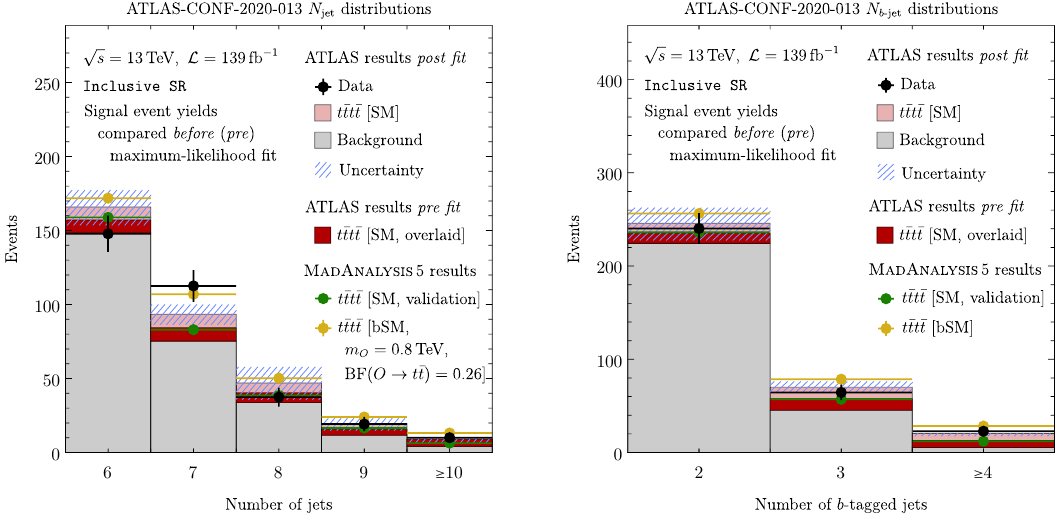
Figure 10 . Comparison between data and predictions for inclusive signal region events for the dis- tributions of (left) N jet and (right) N b -jet . Gray background results were obtained (and simplified) from figure 6 of ATLAS-CONF-2020-013 [3] and apply after the maximum-likelihood fit. Light (dark) red results were likewise obtained post (pre) fit from ATLAS and are overlaid, not stacked. Green results are derived from MadAnalysis 5 for SM t ¯ tt ¯ t production. Gold results are derived from MadAnalysis 5 for t ¯ tt ¯ t events mediated by a pair of 800 GeV scalar sgluons with branching fraction appropriate to fit thirty-event excess. Our sgluon yields are combined with ATLAS back- grounds and ATLAS pre-fit t ¯ tt ¯ t